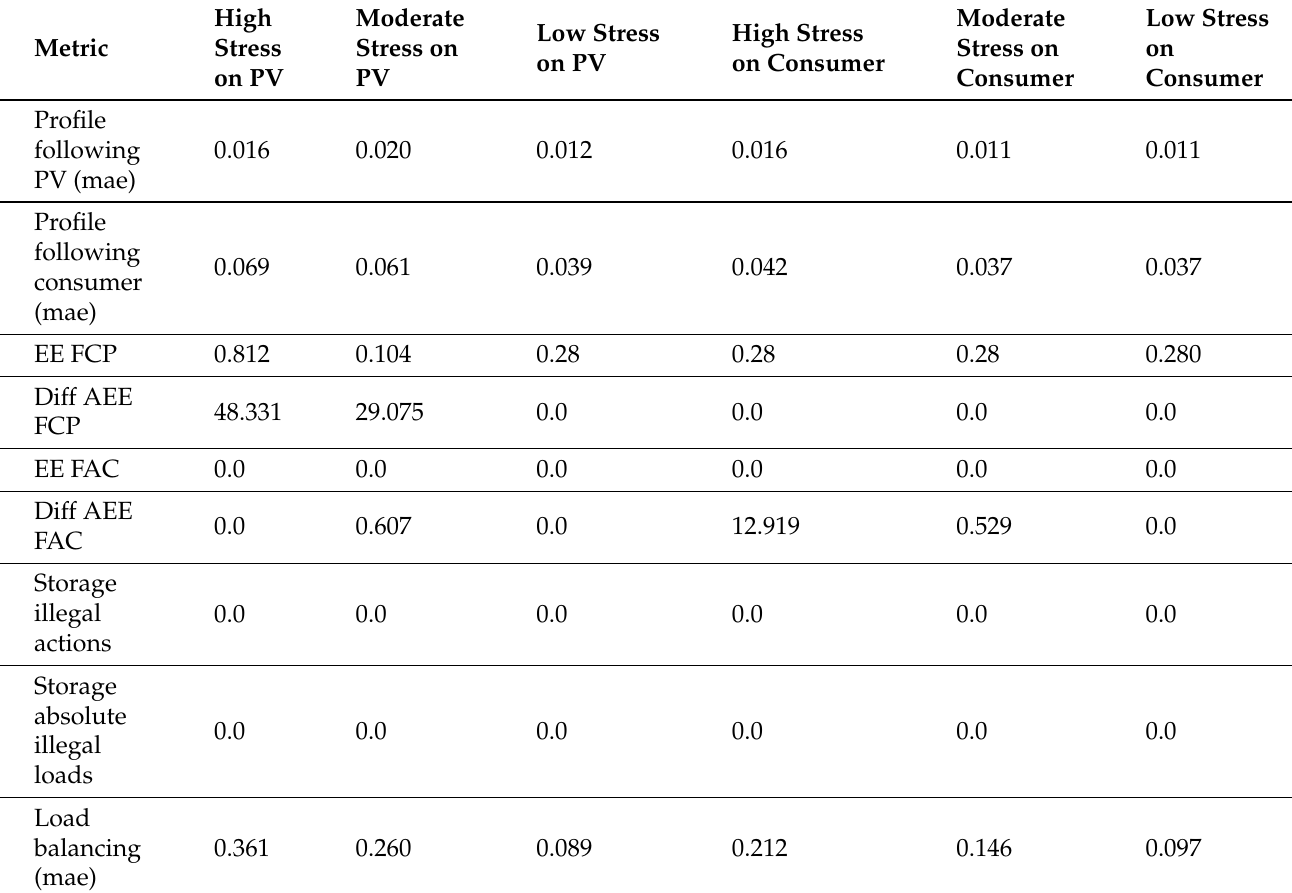
Figure 13. Evaluation of stress on day 1, with the consumer agent stressed moderately. ( a ) Agent load curves and profiles. ( b ) Load balancing difference. Table 7. Single-day training on day 1, evaluation on day 1 with